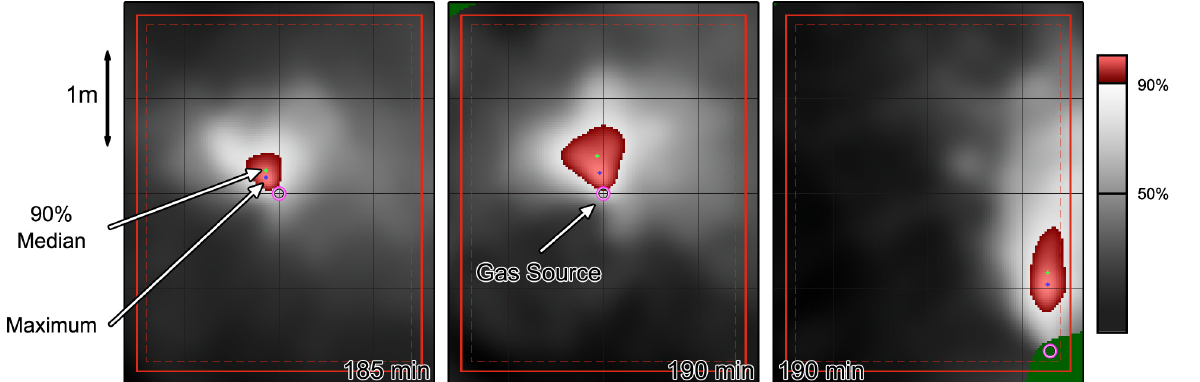
Figure 7 . Examples of kernel-extrapolated gas distribution gridmaps created from concentration data collected with a gas-sensitive mobile robot up to the time specified. The cell size is 2.5 × 2.5 cm 2